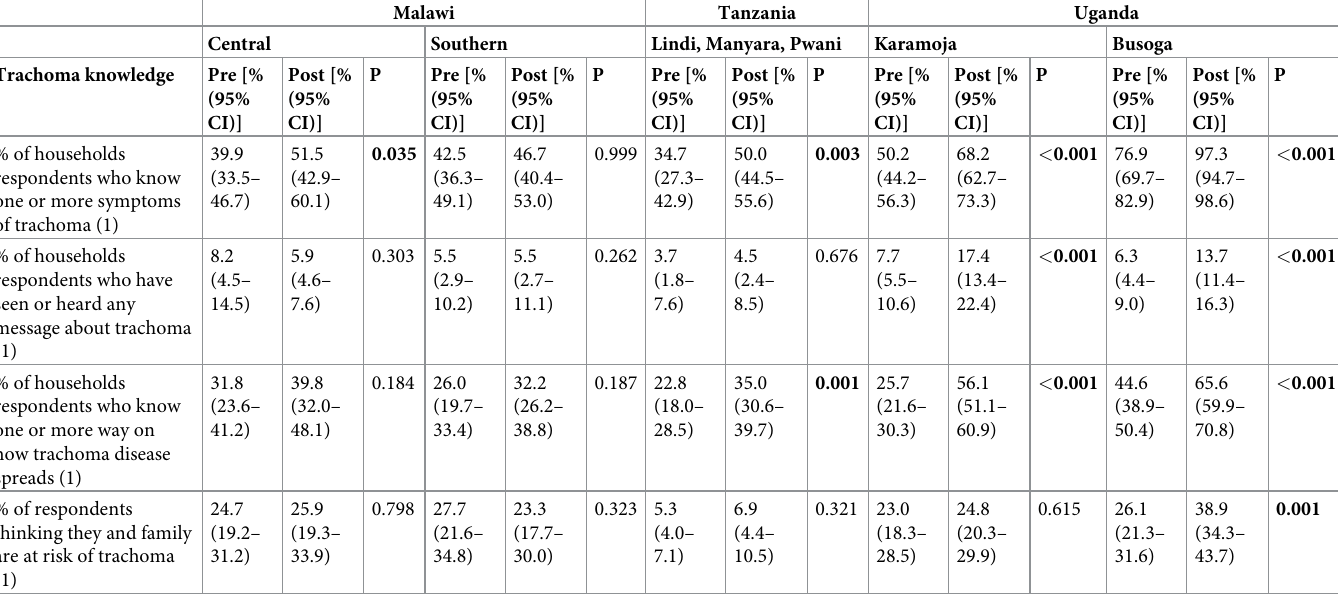
Table 6. Trachoma knowledge survey results by community evaluation unit at pre and post-surveys.